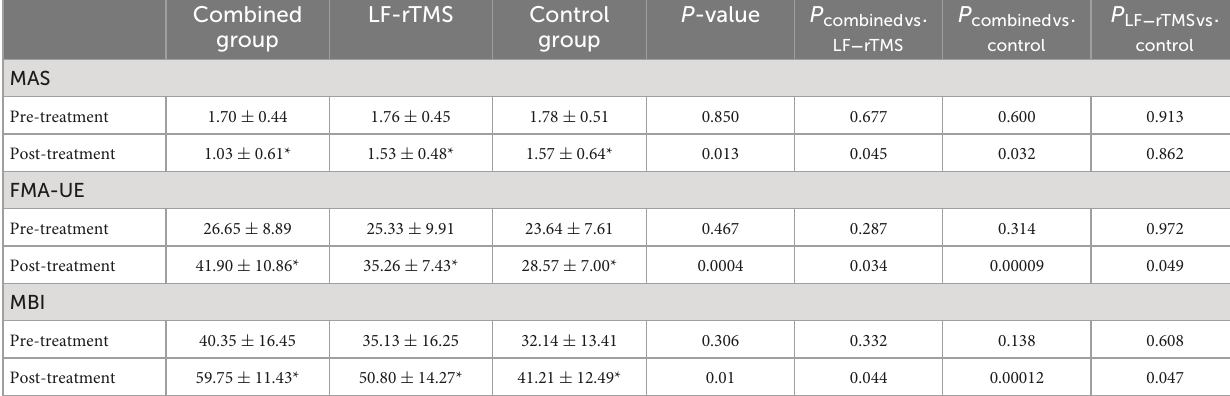
Combined LF-rTMS Control P -value P combinedvs . P combinedvs . P LF − rTMSvs . group group LF − rTMS control control